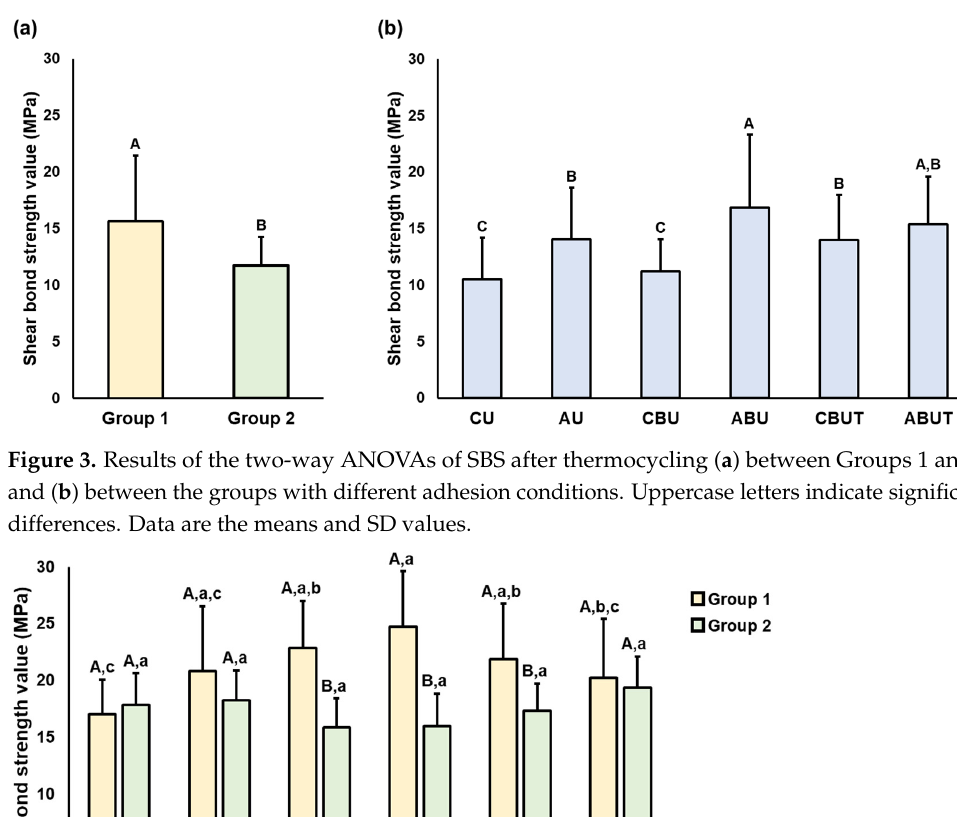
Figure 2. Results of the two-way ANOVAs of shear bond strength (SBS) before thermocycling ( a ) between Groups 1 and 2 and ( b ) between the groups with different adhesion conditions. Uppercase letters indicate significant differences. Data are the means and SD values.